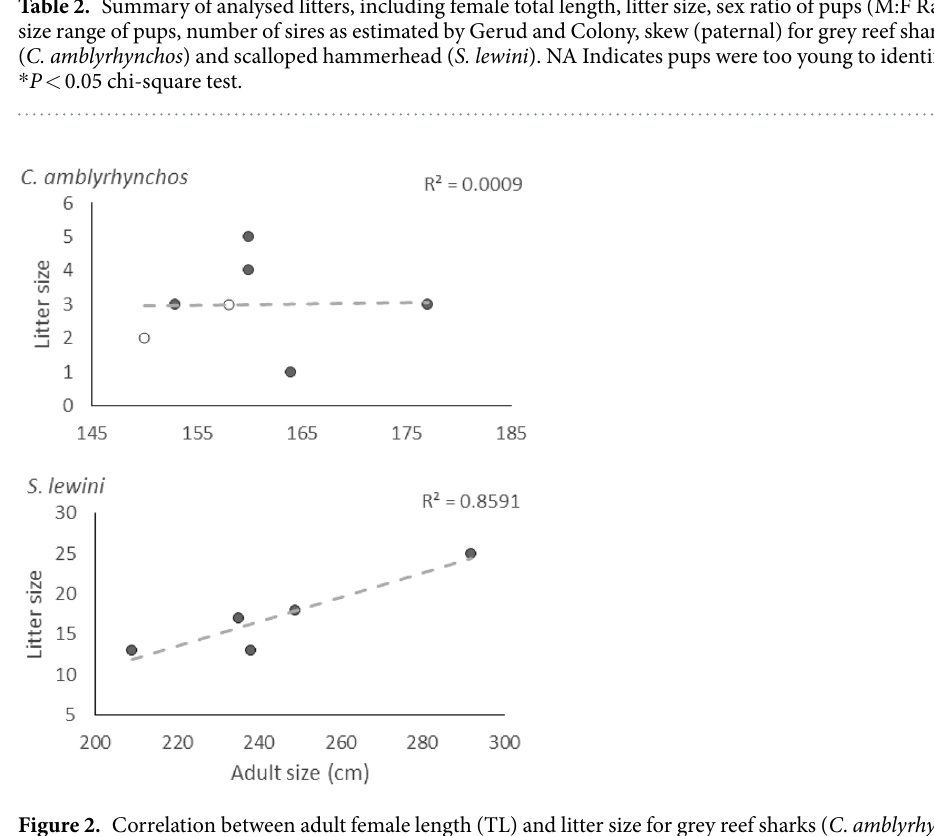
Figure 2. Correlation between adult female length (TL) and litter size for grey reef sharks ( C . amblyrhynchos ) and scalloped hammerhead ( S . lewini ). Shaded points indicate litter with multiple paternity, unshaded represents litters without multiple